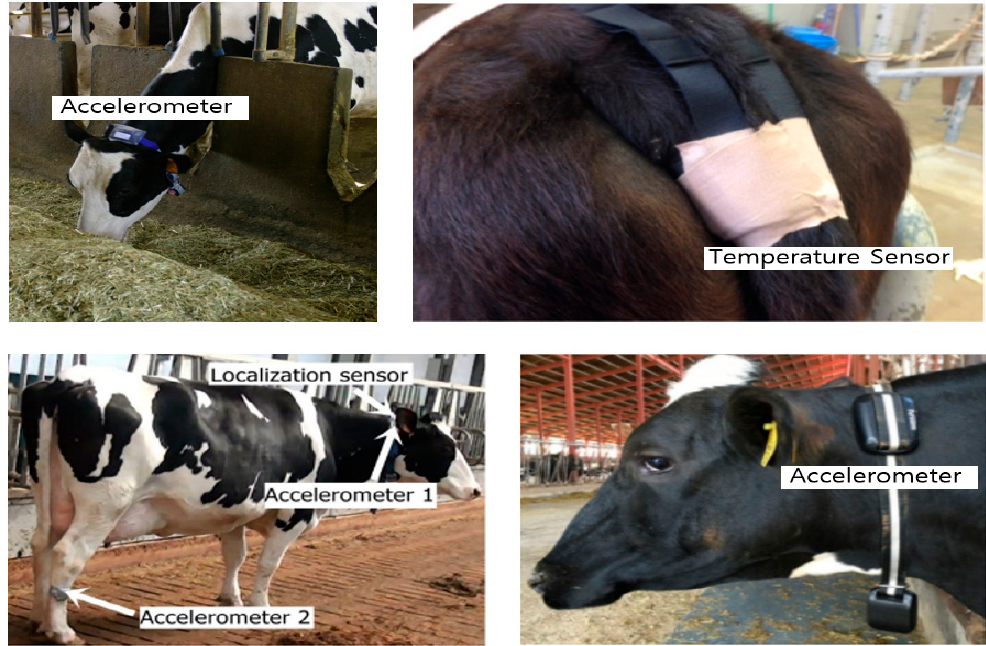
Figure 2. Example application of activity data acquisition method applying an invasive method.